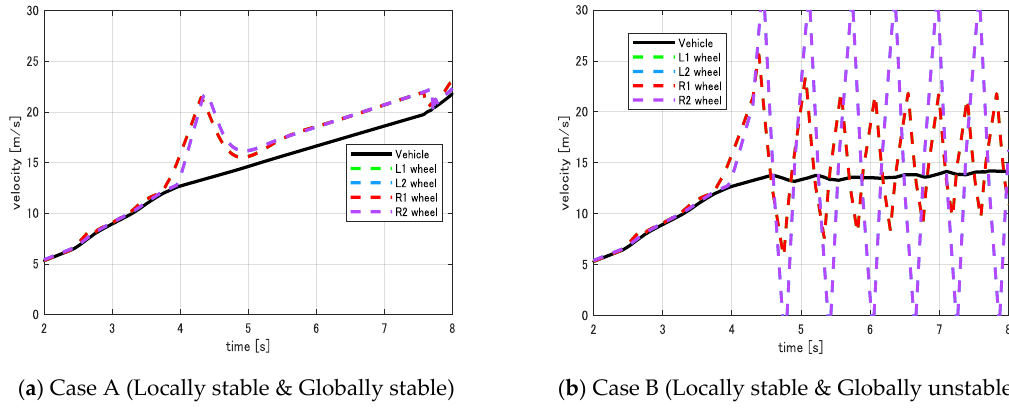
Figure 5. Motivating example: anti-slip control by wheel velocity control.